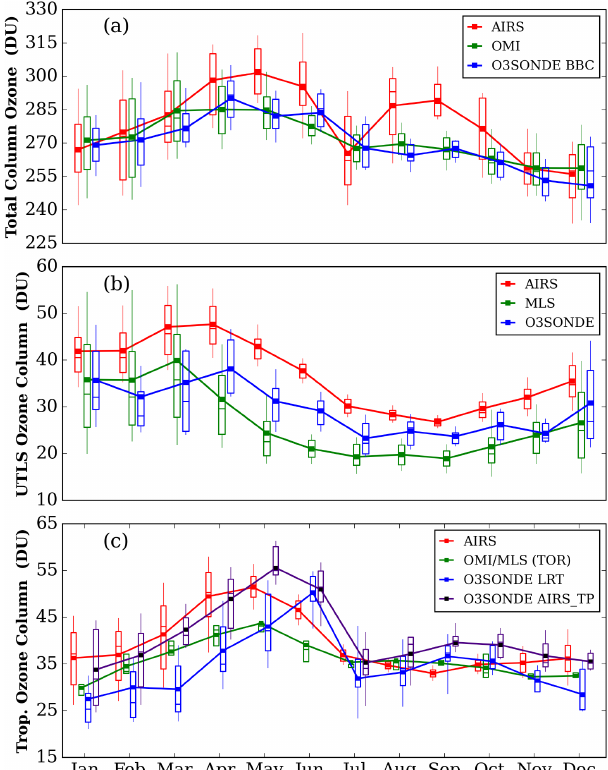
Figure 9. (a) Monthly average variations in total column ozone (TCO) for AIRS, OMI, and ozonesonde (balloon-burst climatology) over the central Himalayas for the 2011–2017 period. (b) Monthly average variation in UTLS ozone column for AIRS, MLS, and ozonesondes over the central Himalayas for the 2011–2017 period. (c) Monthly average variations in tropospheric ozone column of AIRS, OMI and MLS (tropospheric ozone residual), and ozoneson- des (LRT – sonde lapse rate tropopause) over the central Himalayas for the 2011–2017 period. The ozonesonde tropospheric ozone col- umn is also shown using AIRS tropopause (AIRS_TP). In the box plot, the lower and upper edges of the boxes represent the 25th and 75th percentiles. The whiskers below and above are 10th and 90th